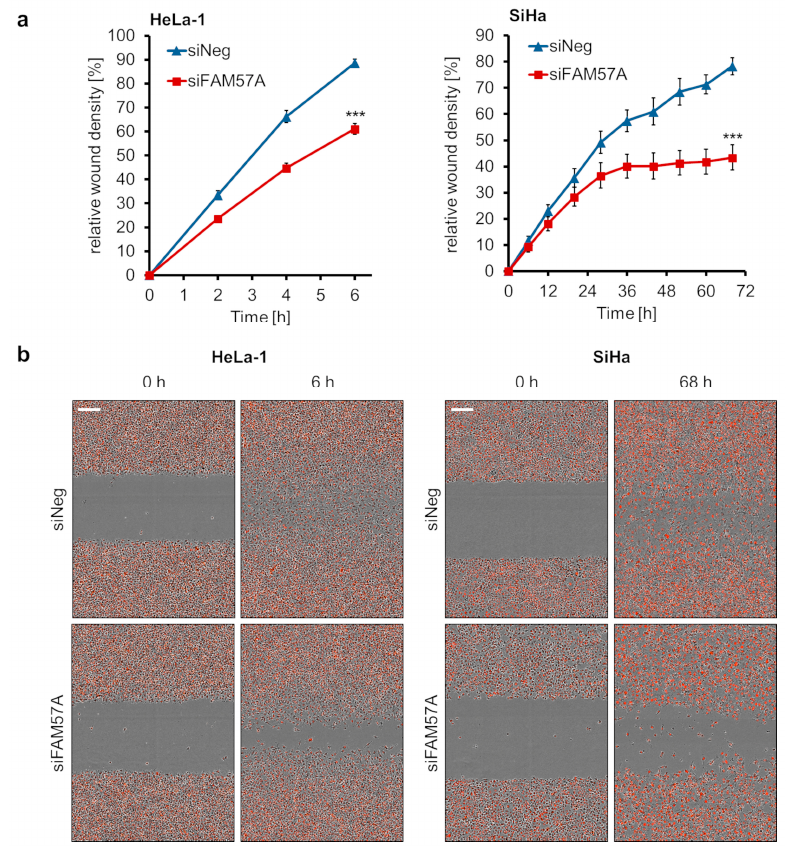
Figure 7. Effects of FAM57A silencing on the migration of HPV-positive cancer cells. ( a ) mKate2- labeled HeLa-1 and SiHa cells were reverse transfected with siFAM57A or control siRNA siNeg and seeded into 96-well plates. Following growth to confluency, standardized wounds were introduced into the cell layers by using the IncuCyte Woundmaker tool. The relative wound density was measured over time by live cell imaging, employing the IncuCyte S3 imaging system. Statistically significant differences of the endpoints are analyzed by student’s t -test. ***: p < 0.001. ( b ) Exemplary microscopic visualization of the cell migration of siFAM57A- or siNeg-transfected mKate2-labeled HeLa-1 and SiHa cells into the wound (time points after scratching: 6 h for HeLa-1, 68 h for SiHa cells). A size marker is indicated in the upper left panel (scale bar: 200 µm).